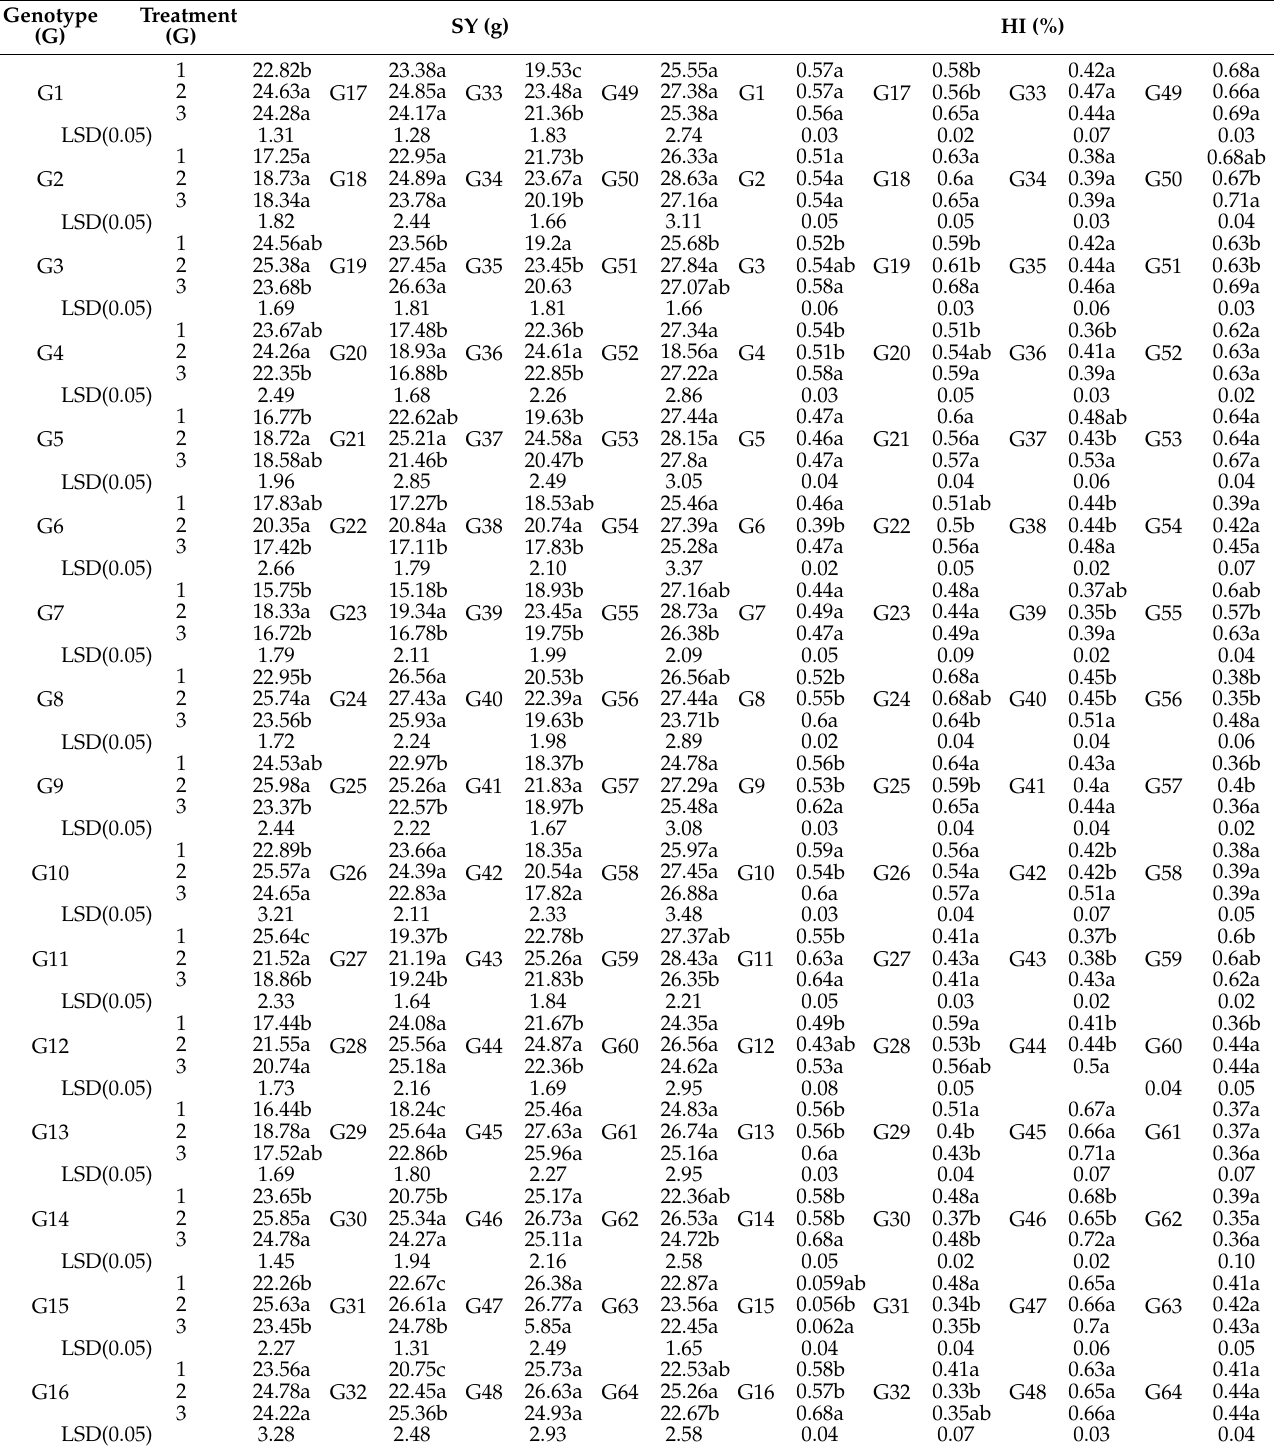
Table 6. Straw yield and harvest index of 64 rice genotypes as influenced by treatment and genotype (pooled over two